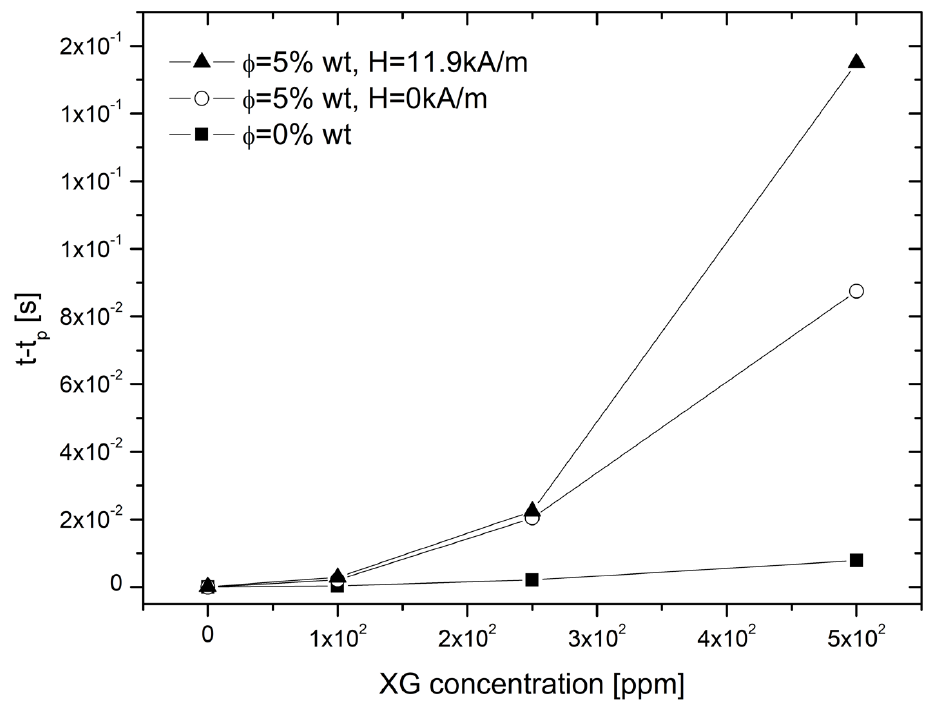
Figure 6. Dependence of the t-t p at the breakup of the filament thinning process due to the presence of magnetic particles and magnetic field.